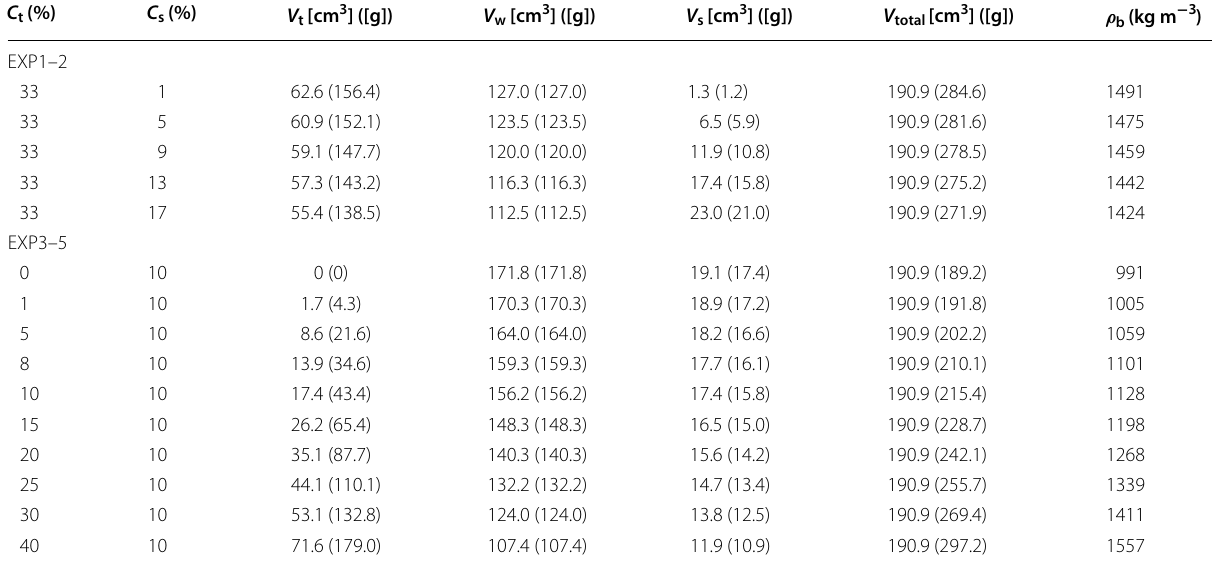
End of volumes and masses of tephra, water, and